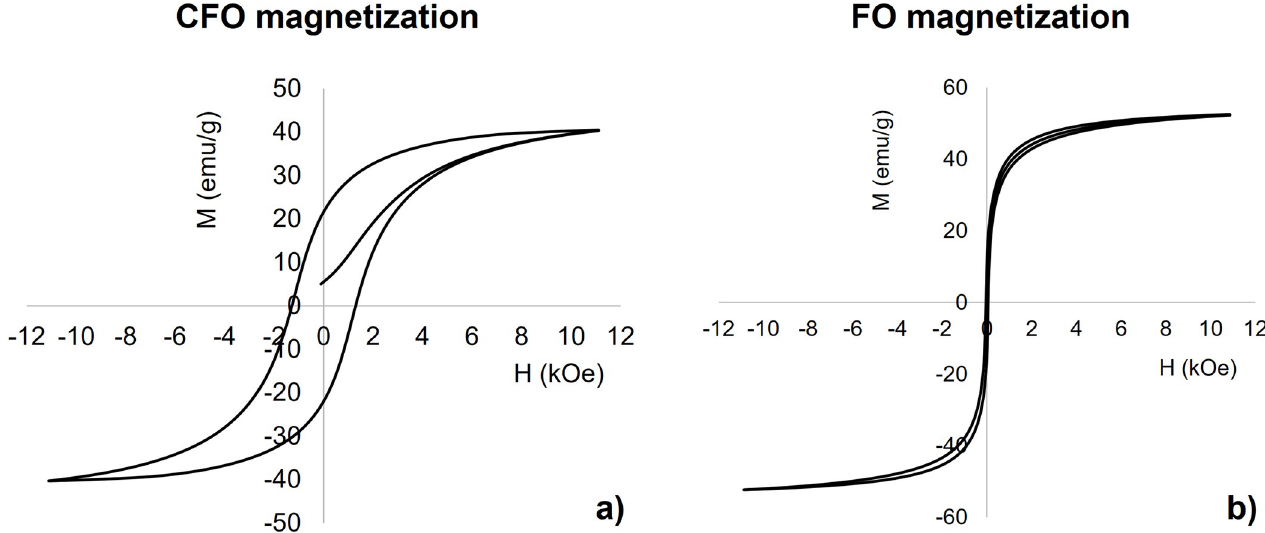
Fig 4. Effect of core and shell size on magnetoelectric coefficient. Trend analysis of variable core size (a and b) and shell thickness (c and d) of CFO-BTO (a and c) and FO-BTO (b and d) MENPs when stimulated with a high strength ( > Ms) DC bias magnetic field directed along z on the magnetoelectric coefficient α ME (V/cm �